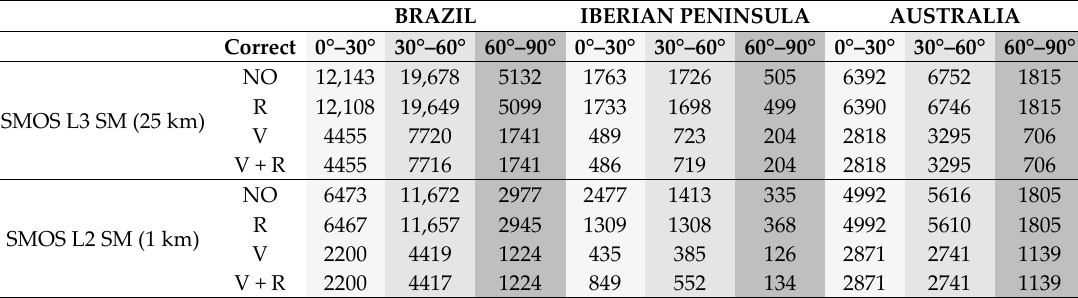
Table 4. Number of points of the regression lines shown in the Figures 13–15, and SMOS L2 SM (Low Resolutions) and SMOS L3 Soil Moisture (High Resolution). Note: NO” stands for no corrections applied, “R” for surface roughness correction applied only, “V” for vegetation corrections applied, and “V + R” for vegetation and surface roughness corrections applied. NO, R, and V cases not presented in Figures 13–15.